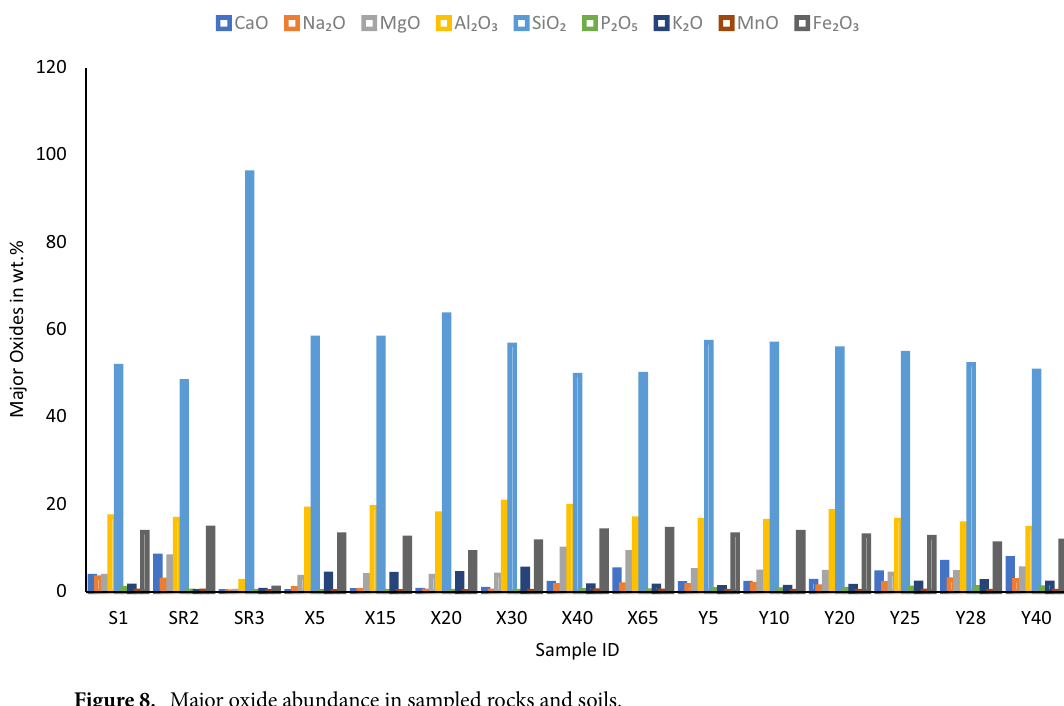
Figure 8. Major oxide abundance in sampled rocks and